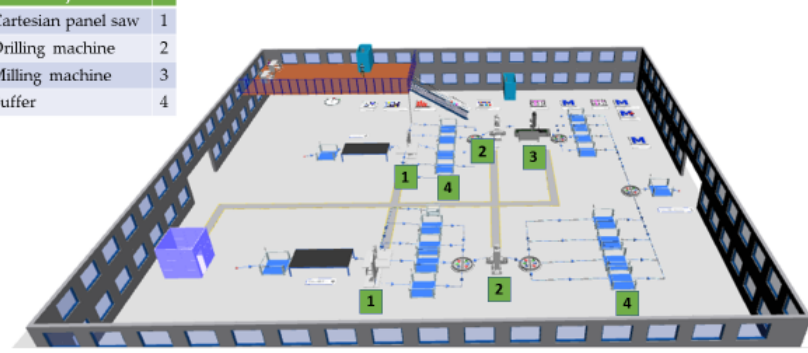
Figure 3. Manufacturing area, built through Siemens Plant Simulation.